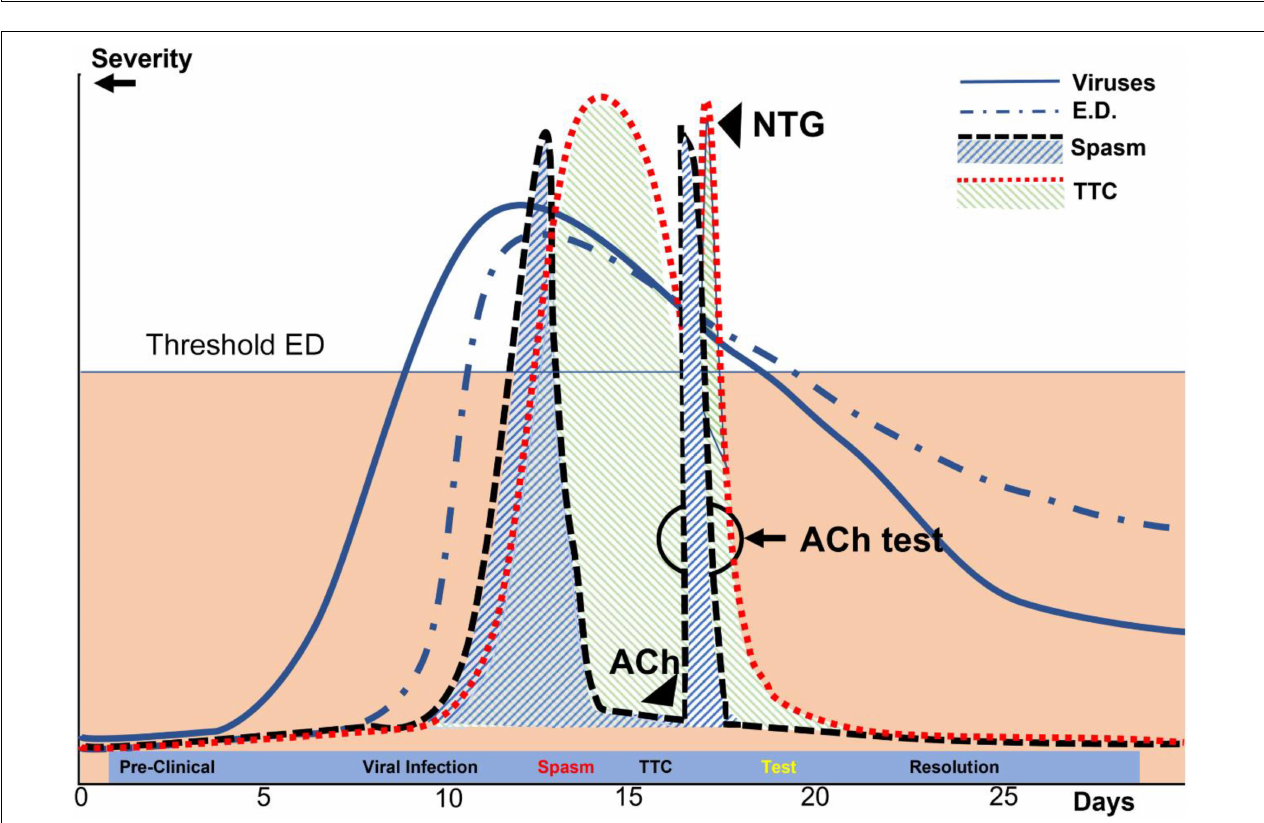
FIGURE 7 | Diagrammatic representation of the processes leading to TTC in patients with COVID-19 over time. In this depiction of our current theory, the y-axis represents the approximate percent change in the maximal possible dysfunction of various parameters, including viral infection, coronary endothelial dysfunction, myocardial dysfunction (TTC), coronary spasm, and ACh testing done during early recovery after TTC. Ach, acetylcholine; ED, endothelial dysfunction; NTG, nitroglycerin; TTC, transient takotsubo cardiomyopathy. The x-axis indicates the number of days since contagion (Day 1).